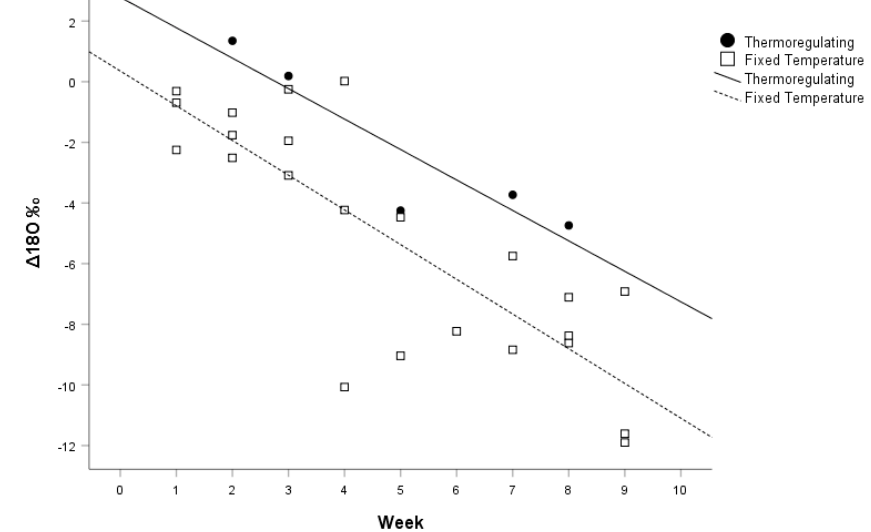
Figure 1. The effect of time and treatment on ∆ 18 O ( ‰ ) of scales of corn snakes. ∆ 18 O was calculated using the average δ 18 O from the scales of four snakes sacrificed before the treatments were assigned (thus, these values were representative of the δ 18 O of scale tissue for snakes raised on Texas water) and then subtracted from δ 18 O of scales from snakes sacrificed each week from the treatment